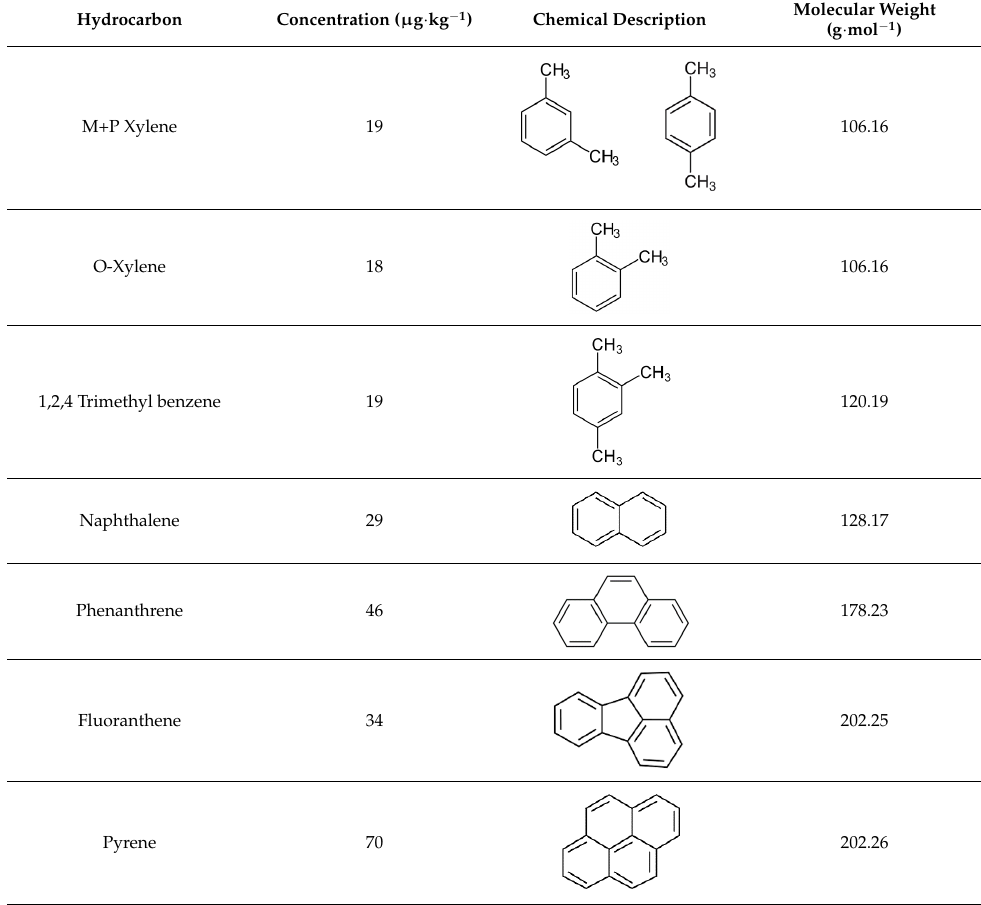
Table 3. Concentrations of aromatic and PAH contaminants in the soil.